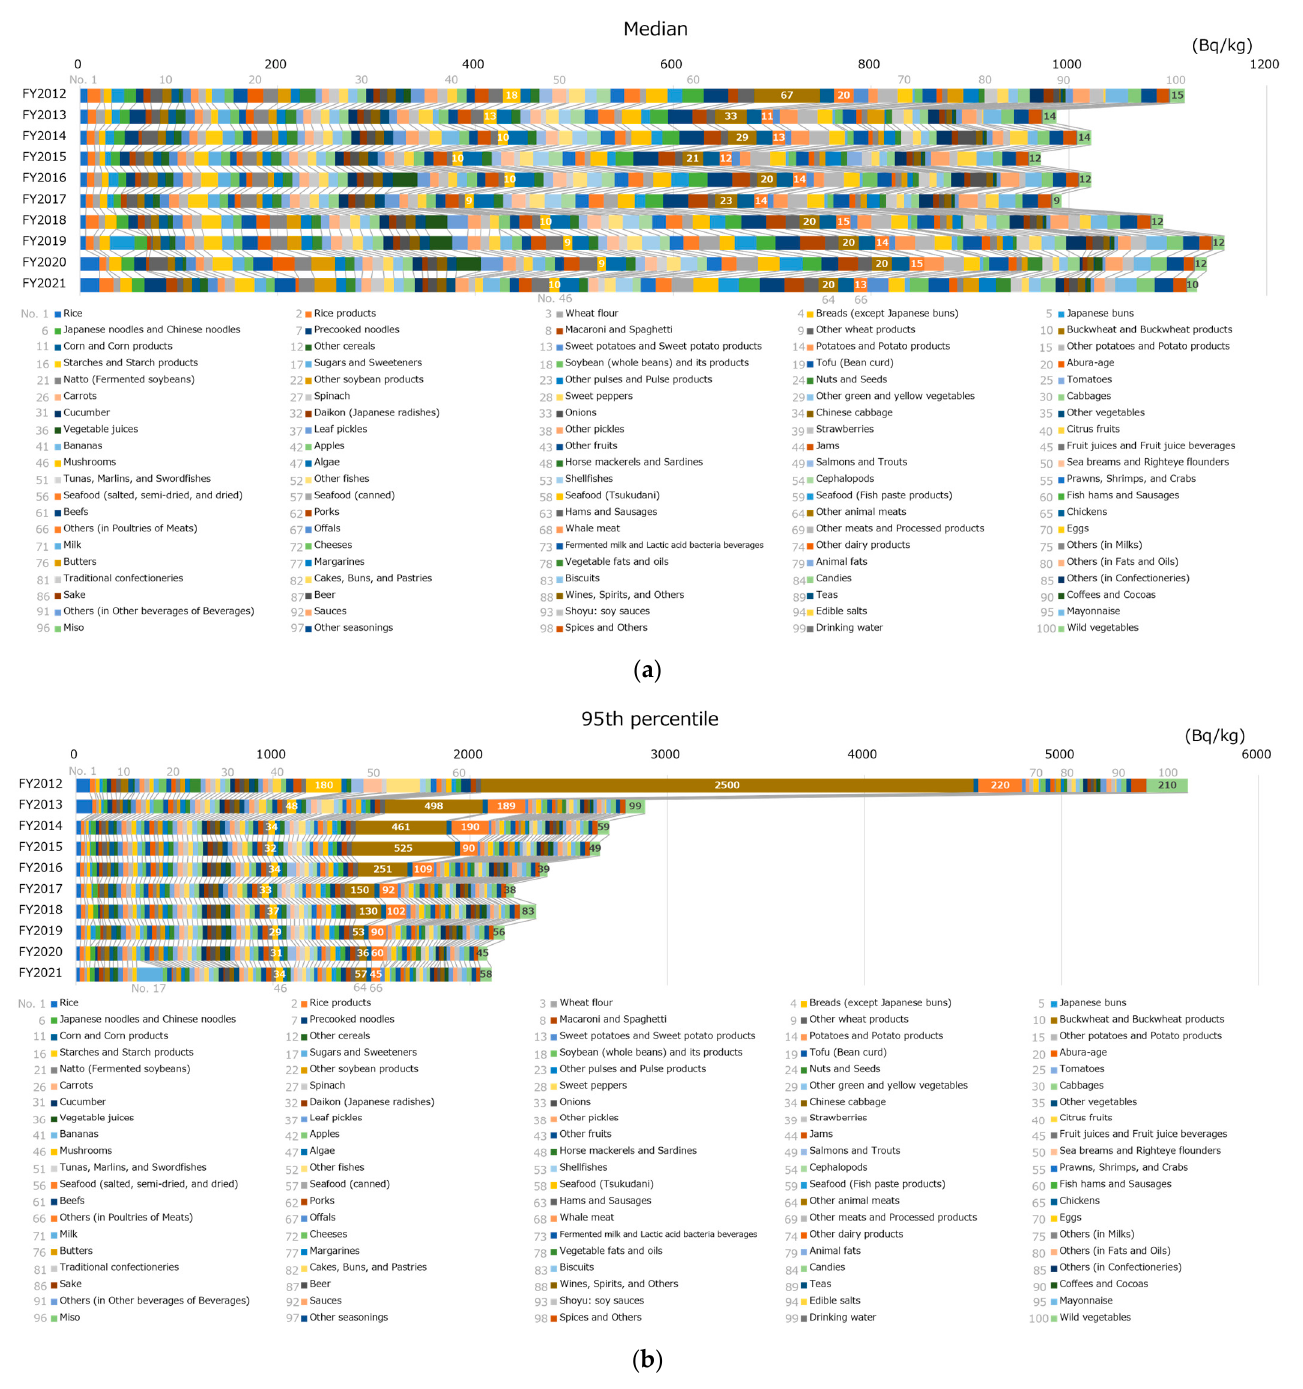
Figure 2. The breakdown of monitoring test results per food classification. The percentile values of radioactivity concentration in each food category were obtained, and the values for all food categories were summarized for each percentile: ( a ) the median and ( b ) the 95th percentile. Results below the limit of detection (LOD) were analyzed as the activity concentration of the LOD. The numbers of the radioactivity of mushrooms, other animal meats, others (in poultries of meats), and wild vegetables are also indicated in the figure as food categories high in radioactivity levels.